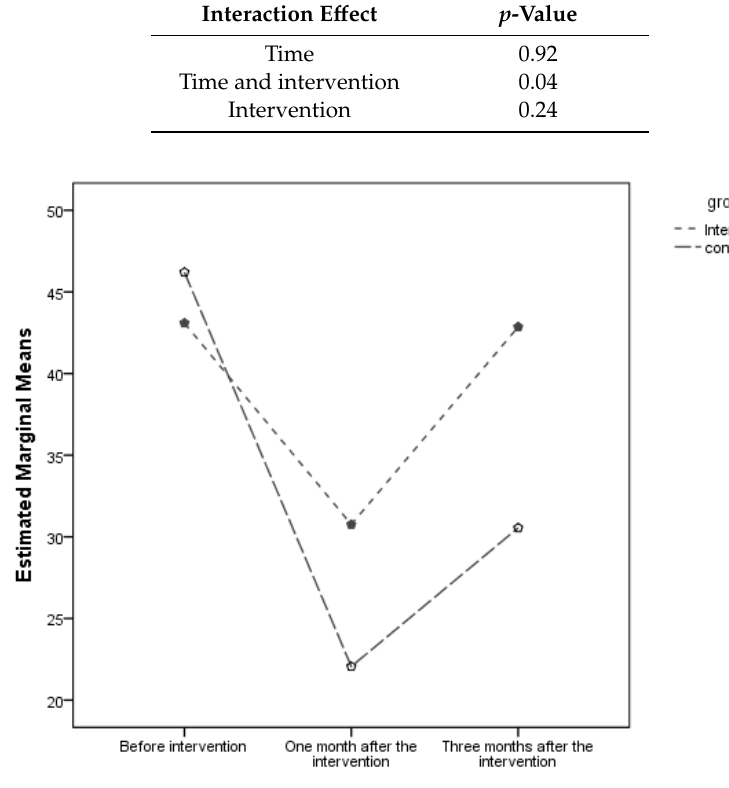
Table 4. E ff ects of the intervention and time on the sexual function. Table 4. Effects of the intervention and time on the sexual function.